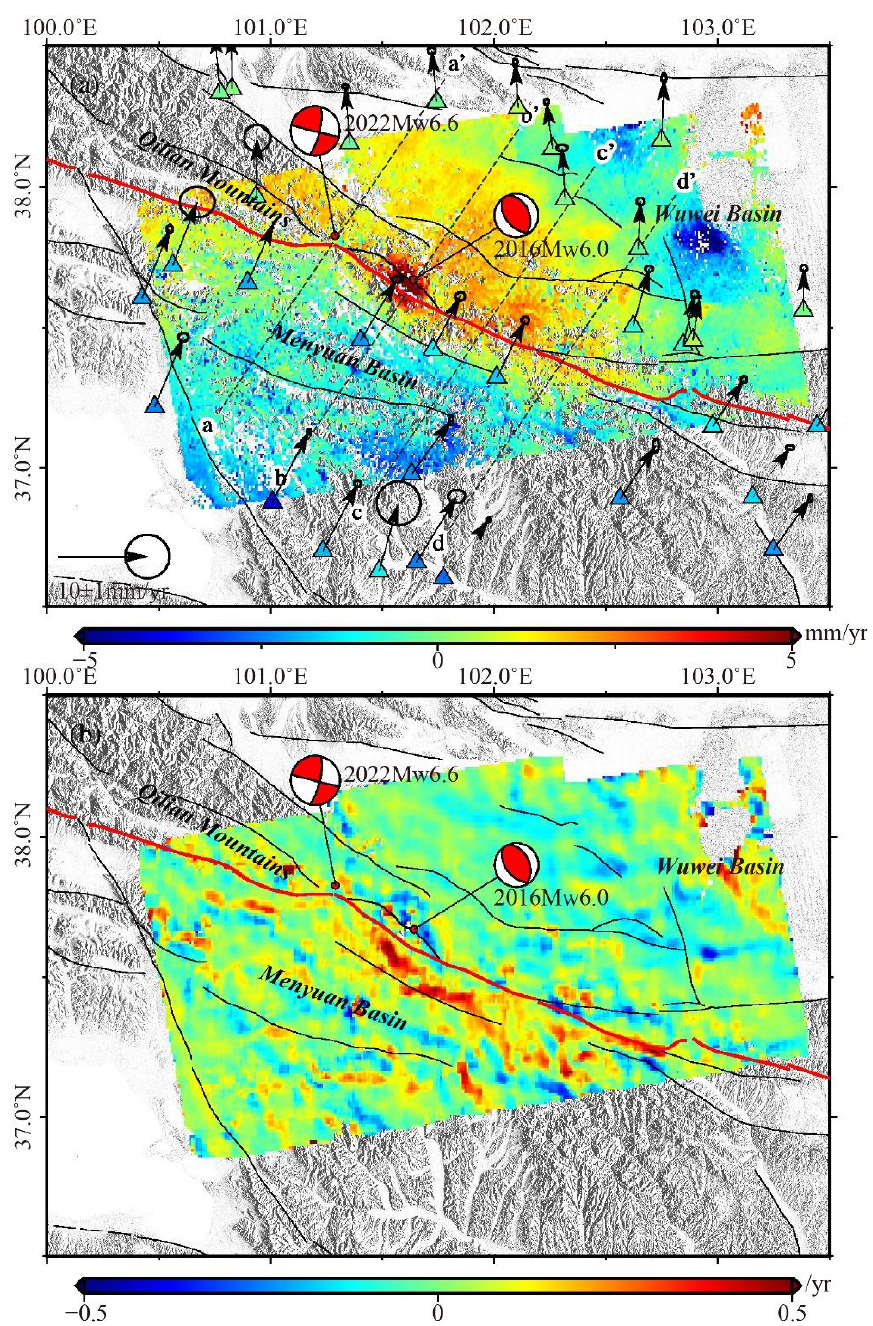
Figure 2. ( a ) Interseismic velocity fields of the Menyuan area from InSAR time-series in the LOS direction. ( b ) Velocity gradient along the N34°E direction. The red line indicates the Qilian-Haiyuan fault system. Black lines show other major faults. GNSS velocities are referenced to the stable Ordos Block [38]. The color-coded triangles represent LOS-converted horizontal velocities of GNSS data, aiding in a comparison with InSAR results.